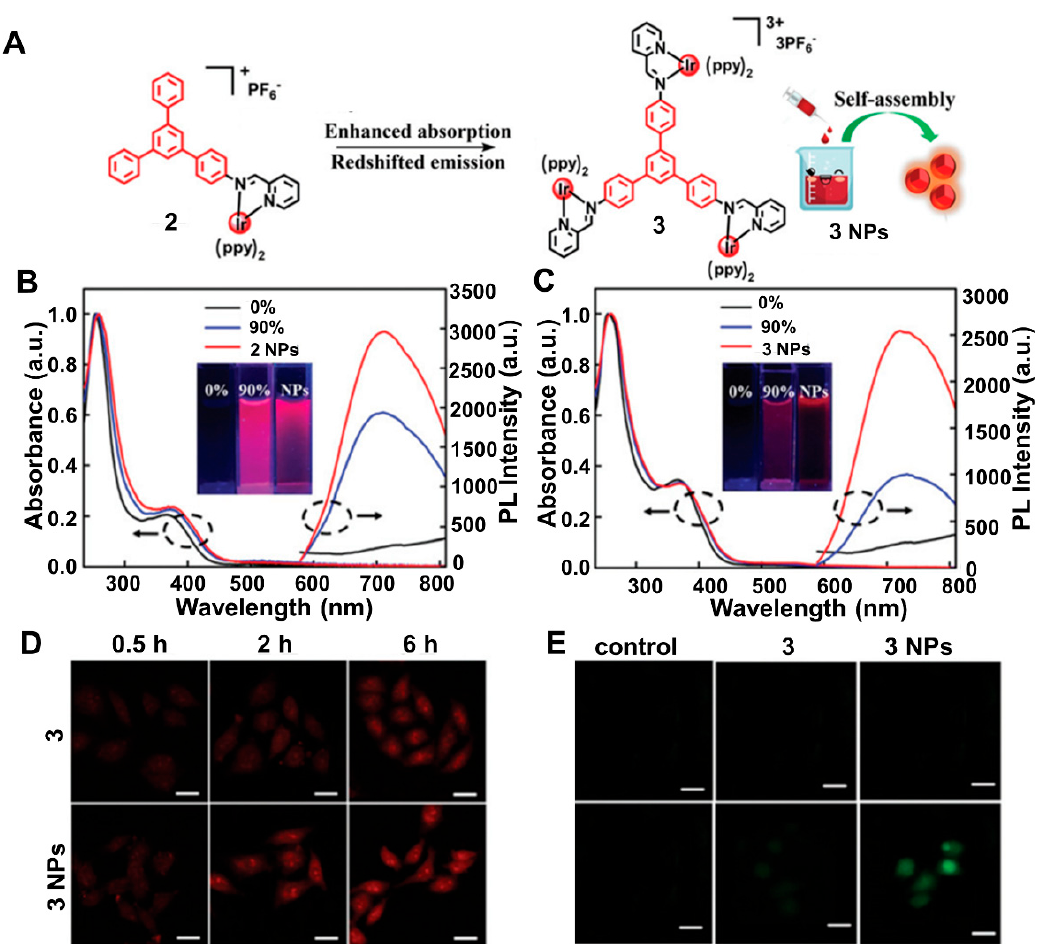
Figure 2. ( A ) Molecular structure of 2 and 3 . ( B ) UV–vis absorption spectra and emission spectra of 2 , 3 (DMSO, DMSO/water = 1/9) and corresponding NPs in water. (The arrows indicate the corresponding ordinate, The circles represent the absorption or emission curve of the materials). ( C ) CLSM images of Hela cells in the presence of 3 and 3 NPs . ( D ) Cellular uptake of 3 and 3 NPs detected by CLSM. ( E ) Confocal fluorescence images for the detection of 1 O 2 generation in HeLa cells treated with 3 and 3 NPs under light. Reprinted with permission from [47], copyright 2020, Royal Society of